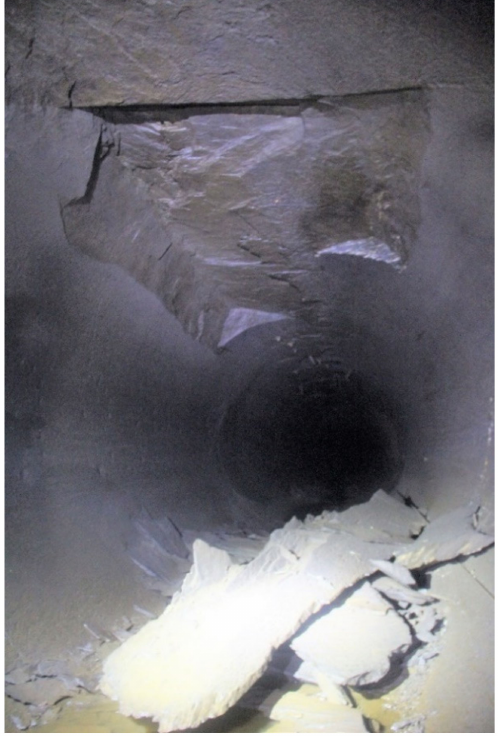
Figure 16. Example of block fall witnessed in Ulset headrace tunnel in